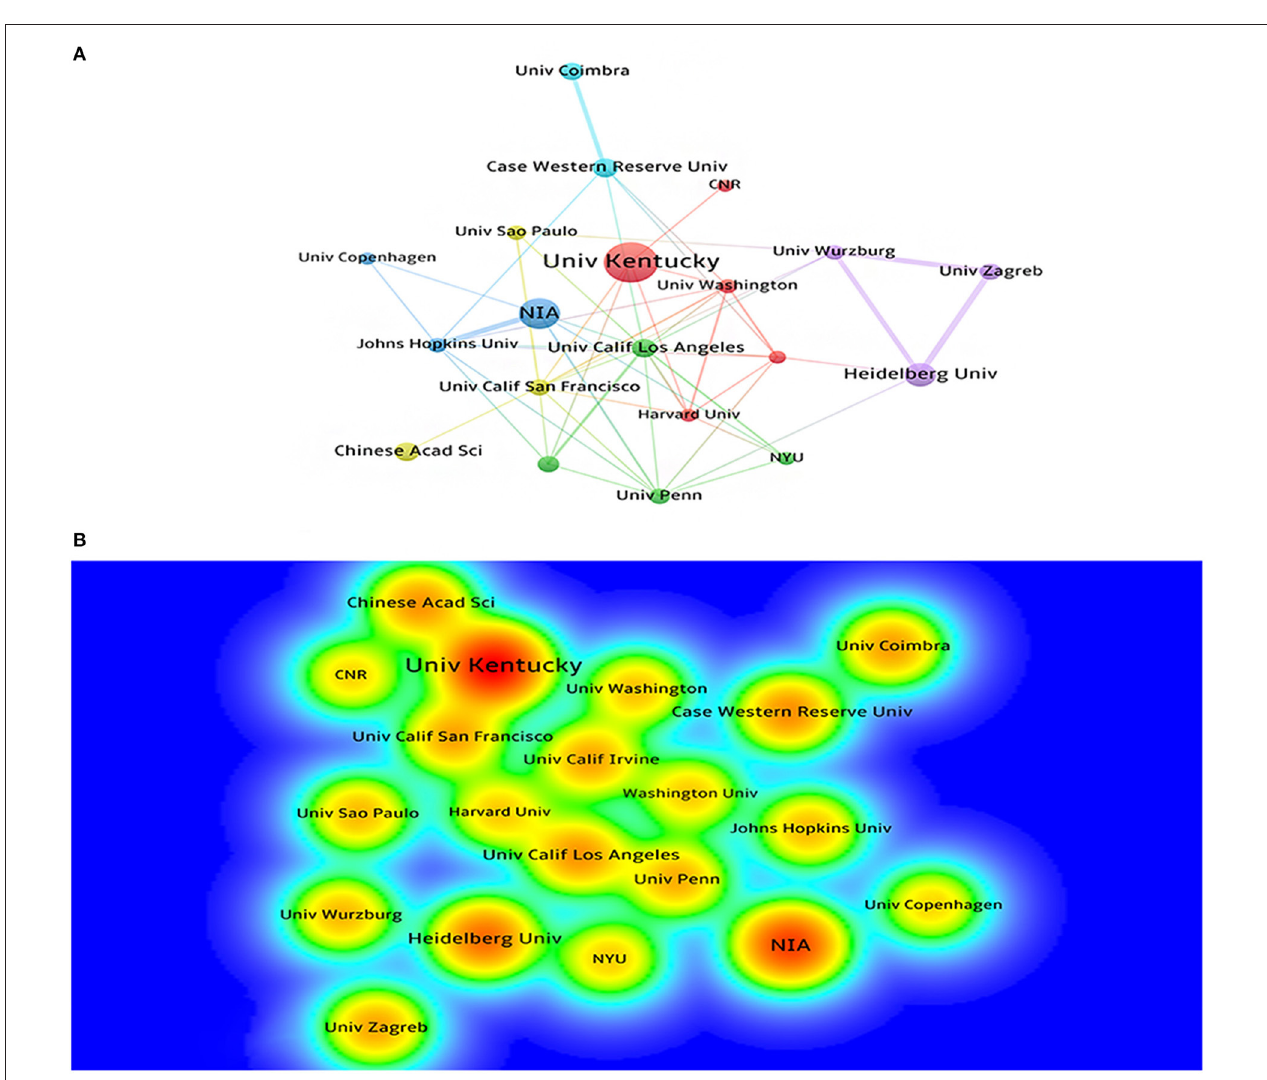
FIGURE 3 | (A) The cooperation network visualization map of institutions based on CiteSpace; (B) The density visualization map of institutions based on VOSviewer.